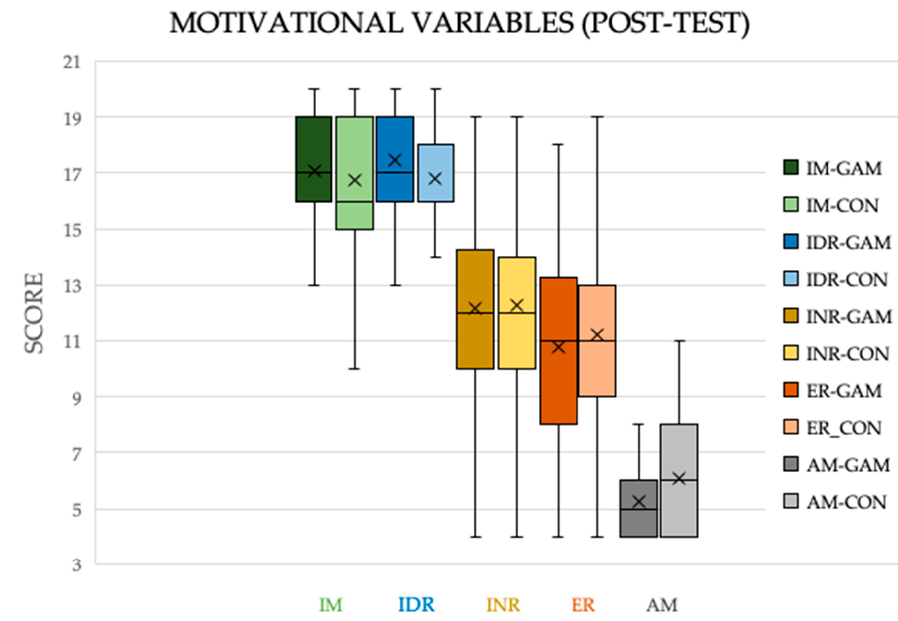
Figure 4. Box diagram of the motivational variables measured in a questionnaire CMEF (post-test). Note: GAM = experimental group; CON = control group; IM = Intrinsic motivation; IR =